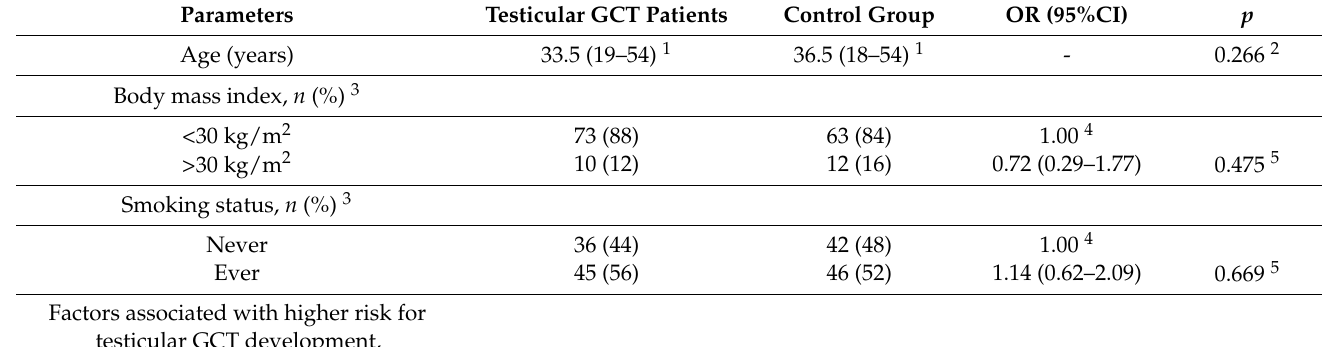
Table 1. The characteristics of patients with testicular GCT and selected